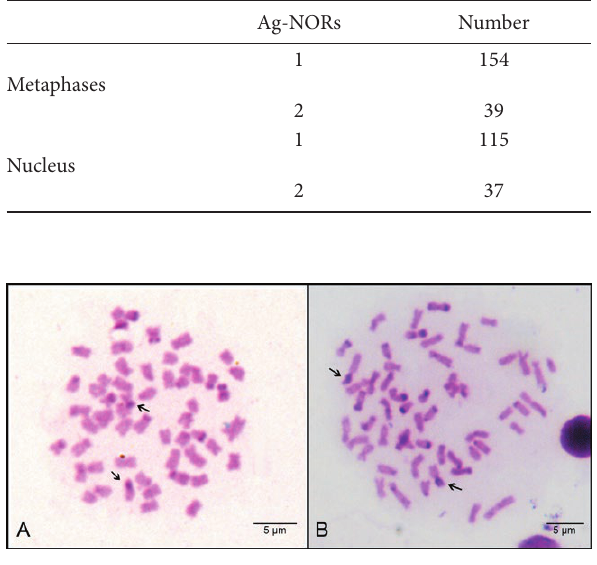
Figure 4. Metaphases of Leiarius marmoratus (A) and the hybrid “cachandiá” (B) after C-banding. Arrows indicate the putative NOR- bearing chromosomes.